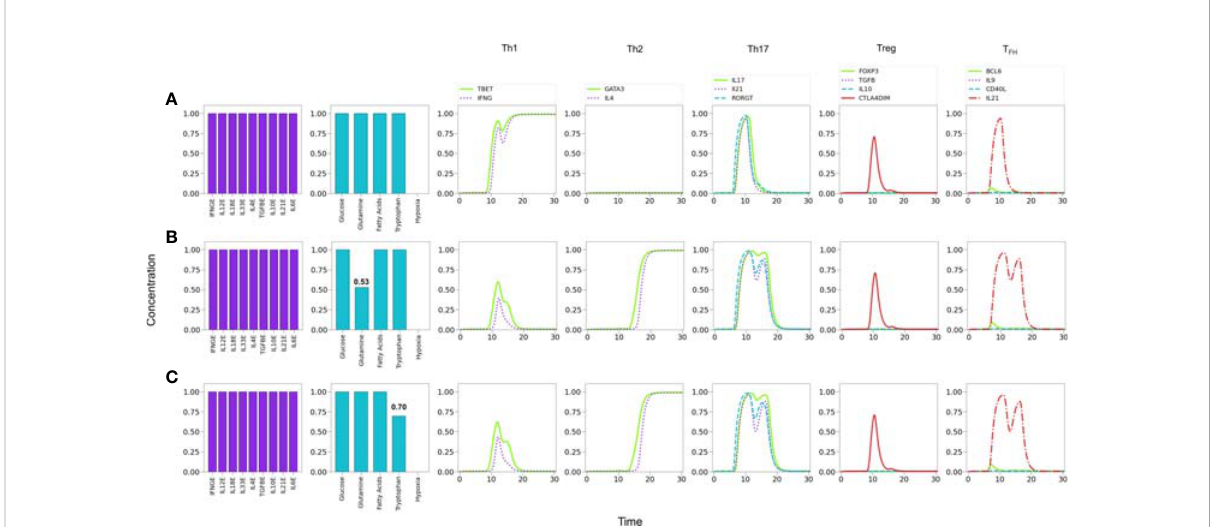
FIGURE 8 Effect of optimal and suboptimal levels of glutamine (GLN) and tryptophane (TRP) on CD4 + T cell differentiation dynamics in the presence of an all-type mixture of exogenous cytokines. (A) Optimal levels of GLN and TRP induce a Th1 phenotype, with transient expression of the Th17 pro fi le and CTLA-4. (B) GLN de fi ciency perturbs Th1 expression; at a critical level GLN = 0.53 a Th2 phenotype is promoted, while Th1 is inhibited. The transient expression of Th17 and T FH traits increases with respect to the fi rst case. (C) TRP de fi ciency also perturbs Th1 expression; at a critical level GLN = 0.70 a Th2 phenotype is promoted, while Th1 is inhibited. As before, the transient expression of Th17 and T FH traits increases. It can be observed that de fi ciency of GLN or TRP induces a similar differentiation dynamics, with a higher sensitivity to reduced TRP